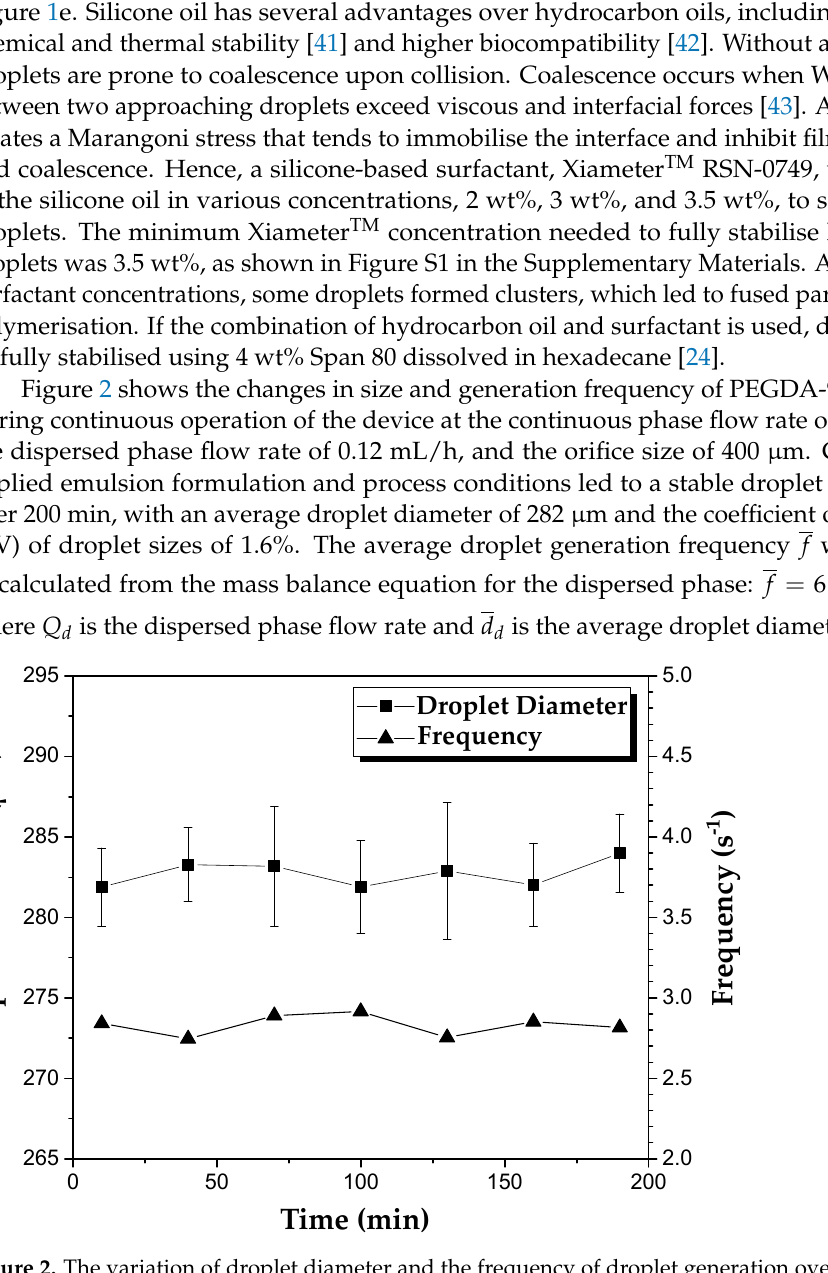
Figure 2. The variation of droplet diameter and the frequency of droplet generation over time in the device with an orifice size of 400 µ m. The flow rates of the continuous and dispersed phase used were 0.6 mL h − 1 and 0.12 mL h − 1 , respectively. The dispersed phase was composed of 99 wt% PEGDA and 1 wt% photo-initiator.